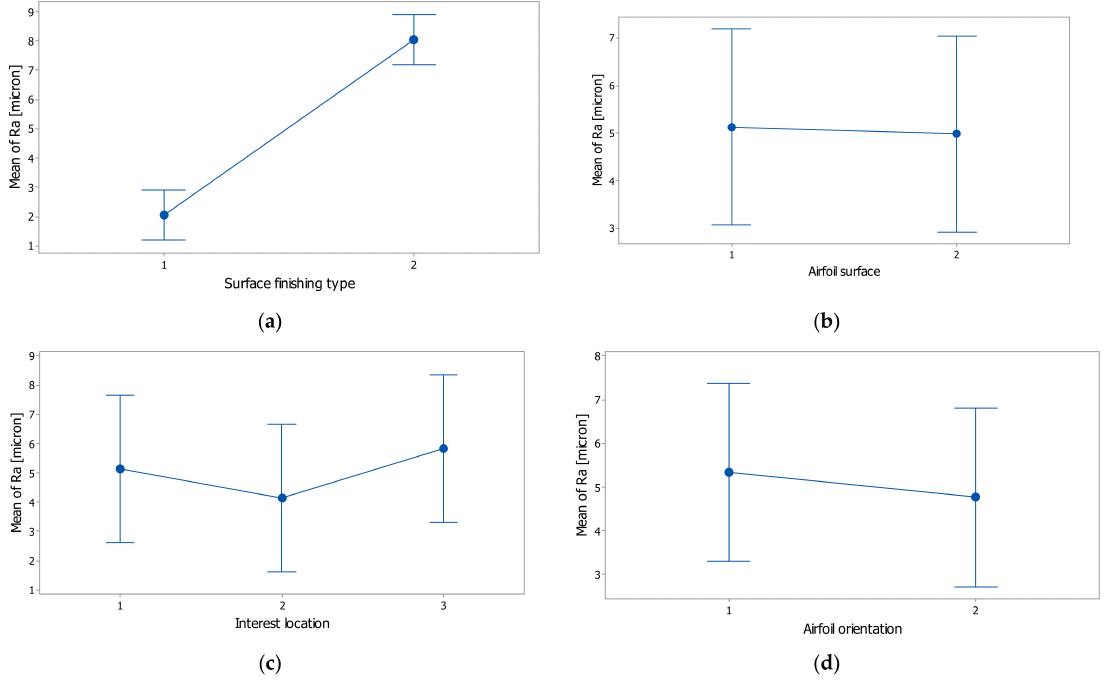
Figure 12. Individual standard deviations were used to calculate the intervals plot of surface roughness (Ra) versus ( a ) surface finishing type, ( b ) airfoil surface, ( c ) interest location, and ( d ) airfoil orientation; bars are standard errors of the